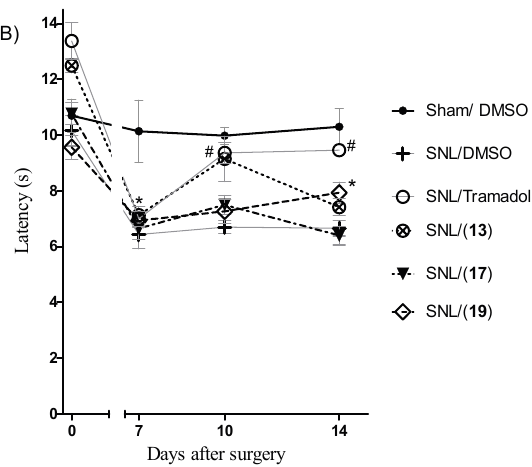
Figure 6. Spinal nerve ligation (SNL) model in rats. ( A ) Treatment of mechanical allodynia for 7 days orally at a dose of 100 μ mol·kg − 1 (tramadol 33.3 μ mol·kg − 1 ), n = 6 animals. ( B ) Treatment of thermal hyperalgesia for 7 days orally at a dose of 100 μ mol·kg − 1 (tramadol 33.3 μ mol·kg − 1 ), n = 6 animals. * p < 0.05 versus day 0. # p < 0.05 versus day